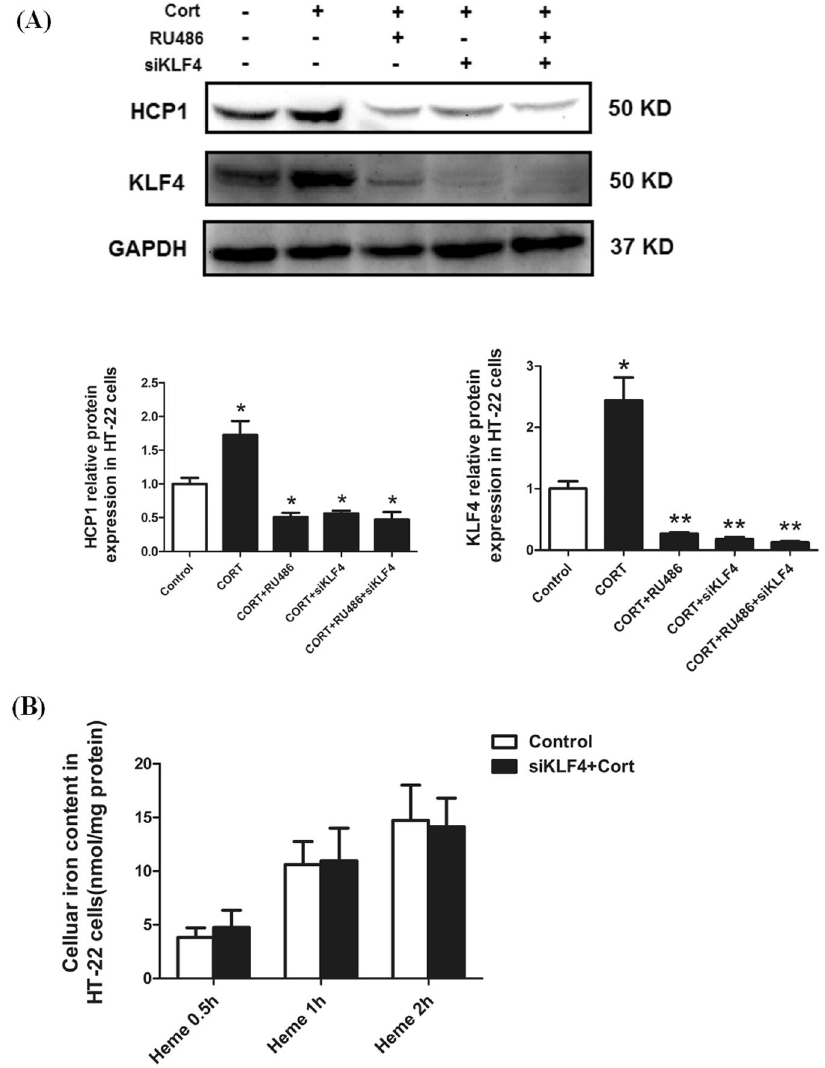
Figure 5. CORT stimulates HCP1 expression through activation of KLF4. ( A ) Western blot showed that HCP1 expression was increased when cells were treated with CORT. However, this effect was abolished when cells were pre-transfected with KLF4 specific siRNA or pre-incubated with the inhibitor of CORT (RU486). ( B ) HT-22 cells were pre-transfected with KLF4 siRNA, then treat with CORT and incubated with hemin. The cellular iron content originally increased by CORT was decreased, and has no differences with the control group. Values are means ± SD. * p < 0.05; ** p <